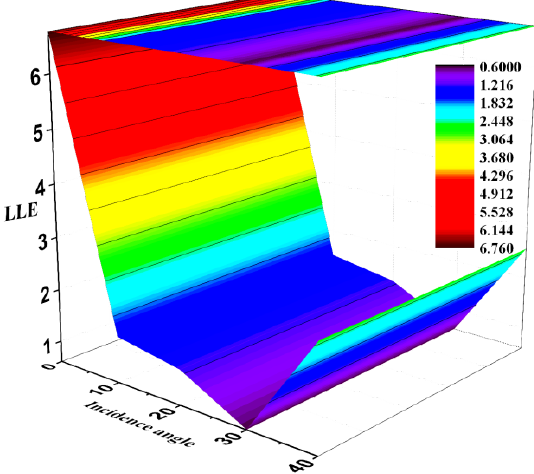
Figure 11. LLE of the pressure signal time series at different incidence angles.